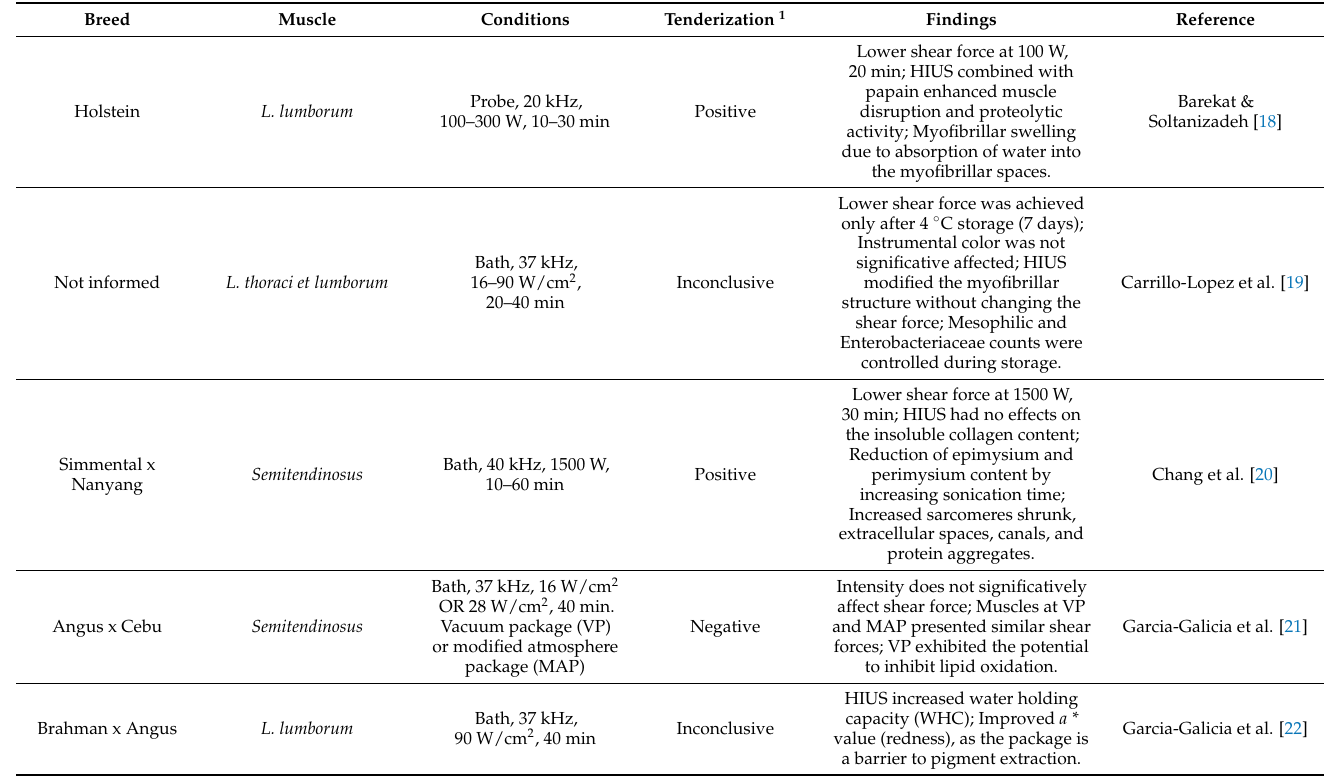
Table 1. Detailed description of the HIUS papers included in this